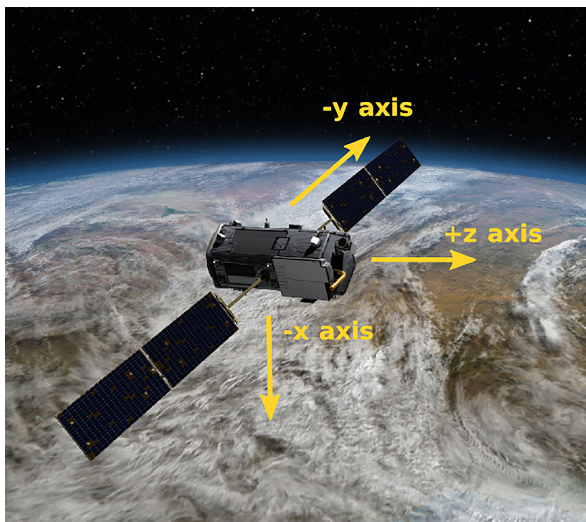
Figure 2. Illustration of the OCO-2 spacecraft body axes.